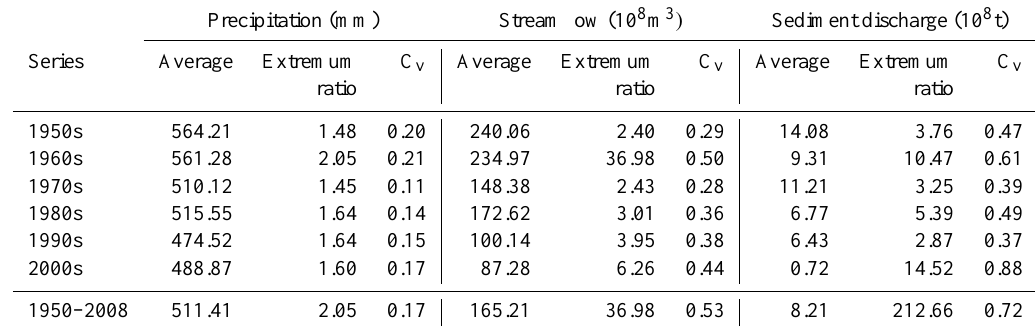
Table 2. Characteristics of precipitation, streamflow and sediment discharge in different decades in the MRYR basin. Precipitation (mm)